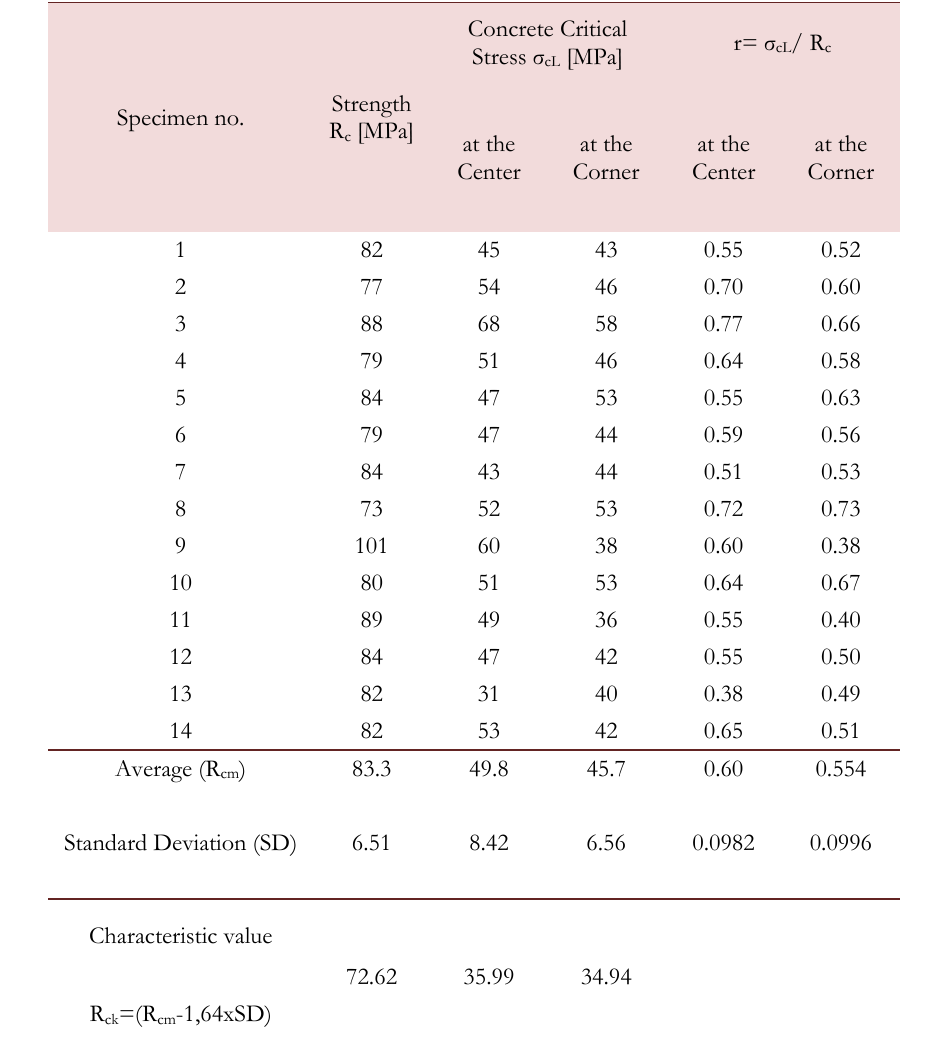
Table 1: cubic strength R c and Critical Stress σ cL of the